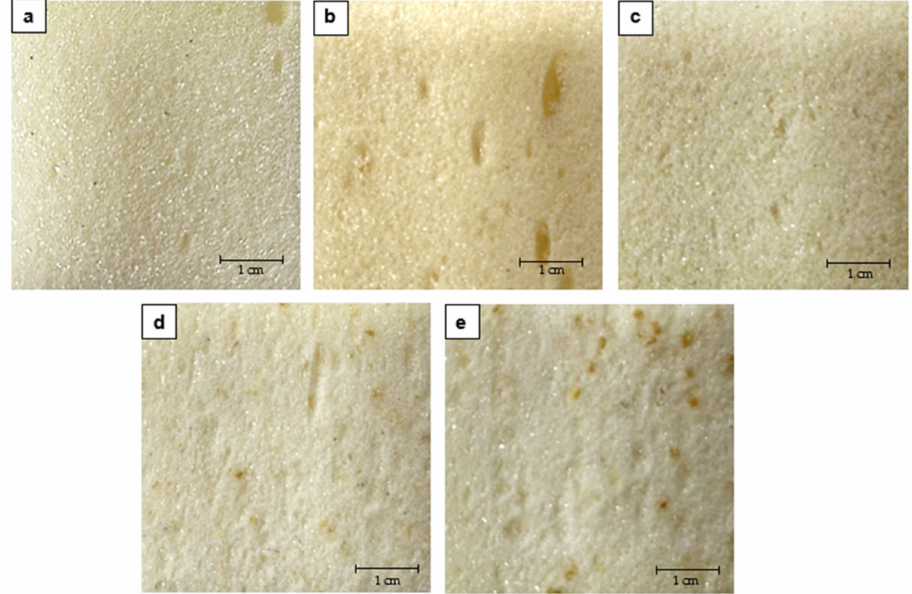
Figure 2. PUR-WP composite structures with different sizes of wood particle: ( a ) reference sample; ( b ) 0.05–<0.125 mm; ( c ) 0.125–<0.315 mm; ( d ) 0.315–1.25 mm; ( e ) >1.25–2.0